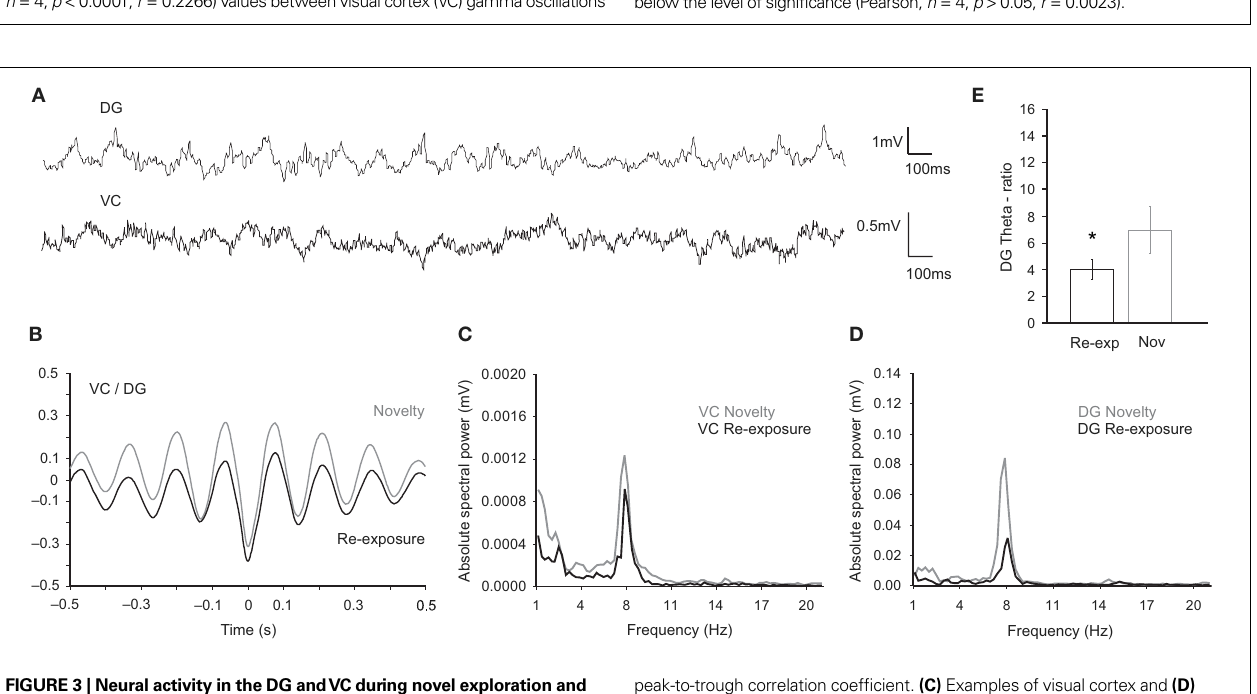
and dentate gyrus (DG) theta-ratio were observed only during the introduction of the novel objects. (B) 5 days later during the re-exposure, the correlation values are below the level of signifi cance (Pearson, n = 4, p > 0.05, r = 0.0023).